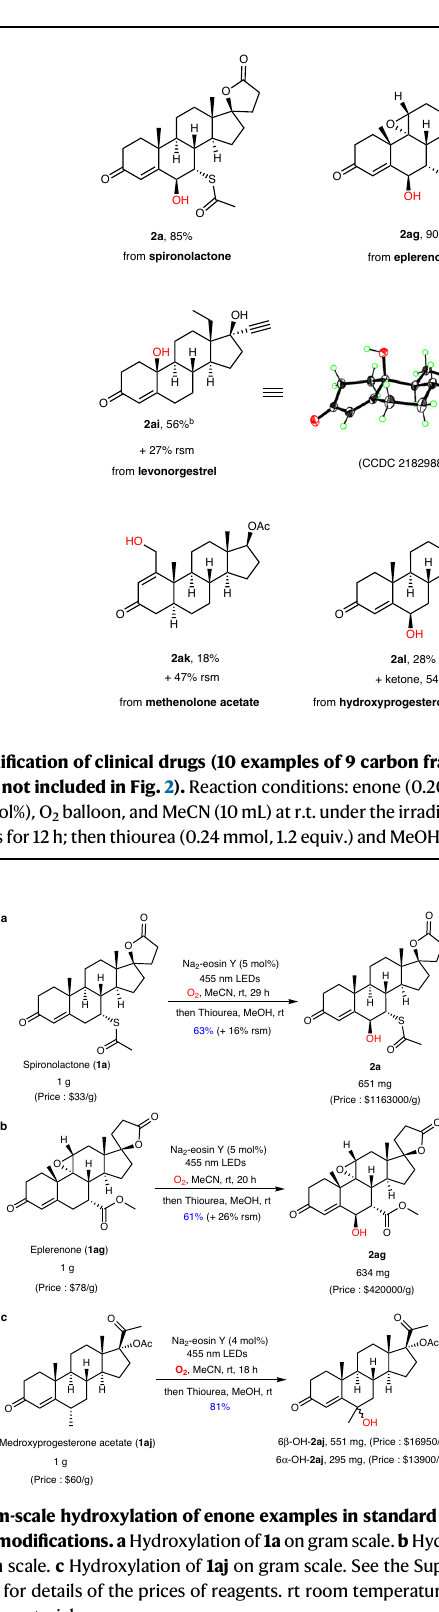
Fig. 4 | Gram-scale hydroxylation of enone examples in standard condition withslightmodi fi cations.a Hydroxylationof 1a ongramscale. b Hydroxylationof 1ag on gram scale. c Hydroxylation of 1aj on gram scale. See the Supplementary Information for details of the prices of reagents. rt room temperature, rsm recov- ered starting